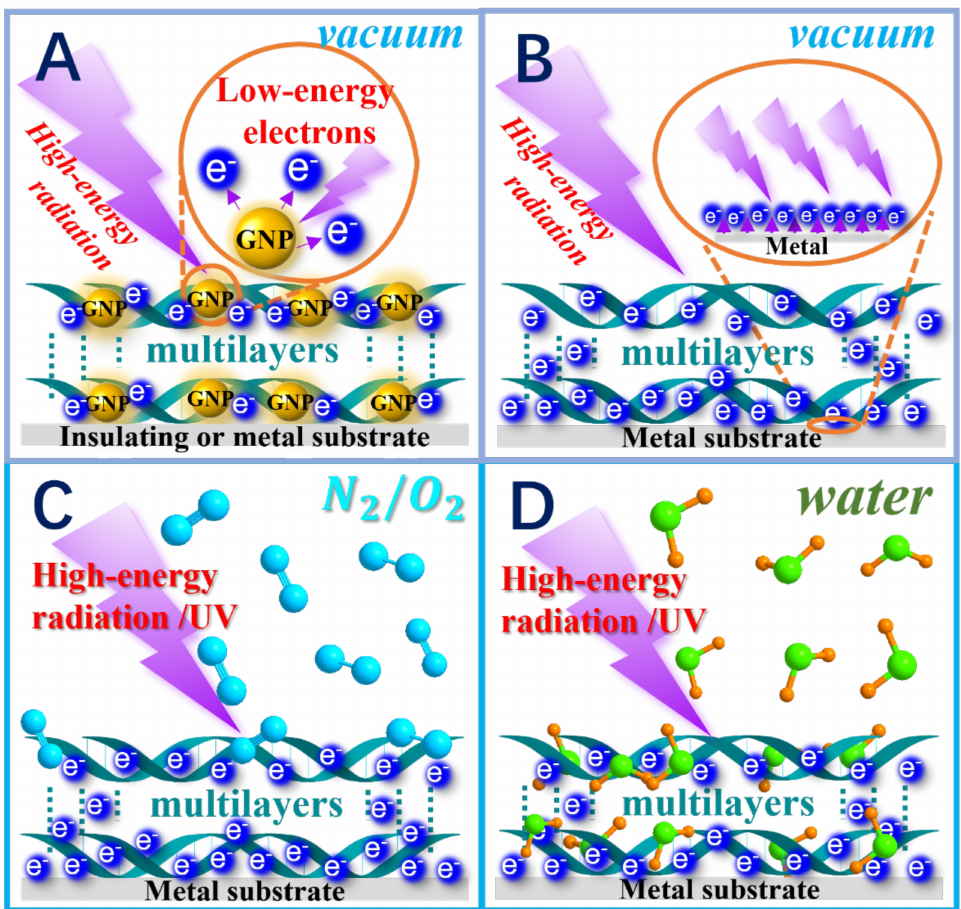
Figure 1. Schematic representation of experiments previously performed with multilayer films of plasmid DNA irradiated with high energy electrons, X-rays or ionizing UV photons. In ( A ), GNPs electrostatically bound to DNA emit Auger electrons that generate short-range (10 nm) LEEs mostly within the multilayer, whereas in other representations, the DNA interact with LEEs ejected from the metal substrate. When the latter is bombarded with 1.5 keV X-rays almost all emitted photoelectrons have energies lower than 30 eV. The multilayer film can be placed in ( B ) vacuum or ( C ) an O 2 and/or N 2 atmosphere at standard atmospheric temperature and pressure (SATP). As shown in ( D ), water can be added in experiment C, to produce different humidity levels (Table 2). The added environmental molecules are absorbed within the DNA structure to simulate LEE irradiation conditions of DNA closer to those of the